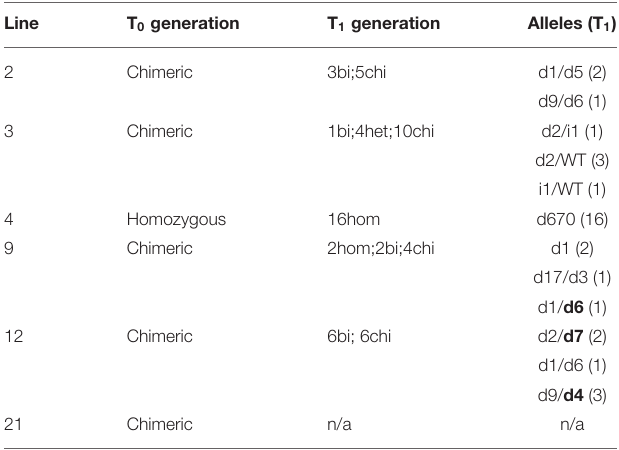
TABLE 2 | Inheritance of CRISPR-Cas9 mutations in the Rubisco small subunit rbcS-T1 .